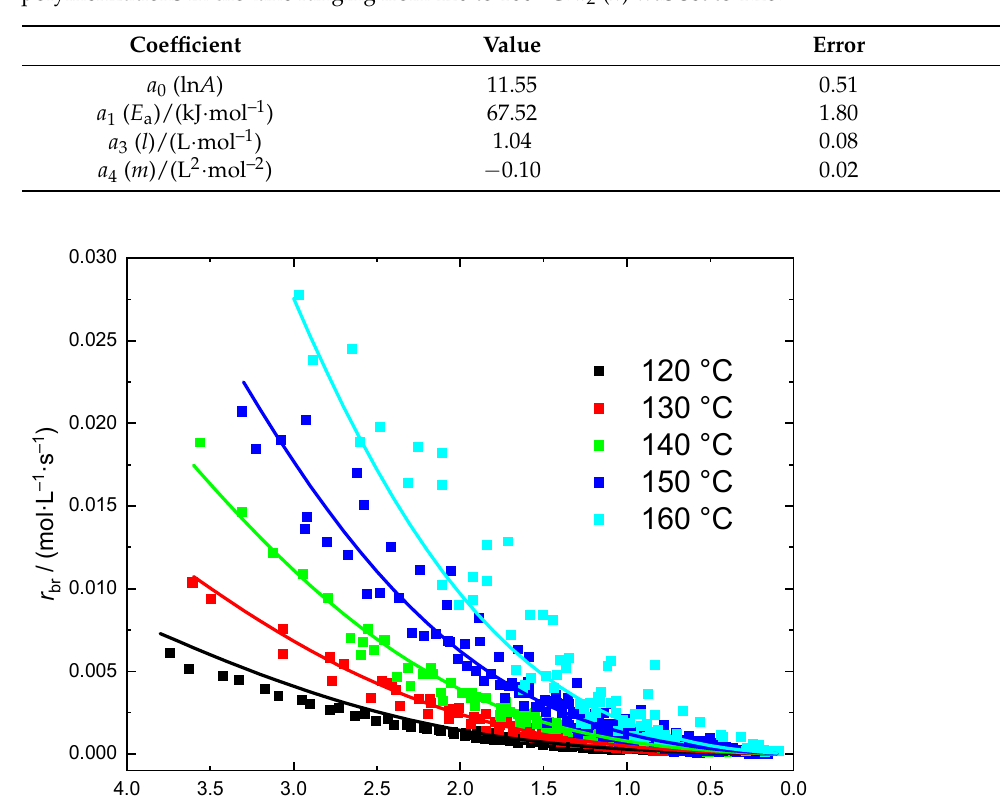
Table 3. Estimated coefficients a 0 , a 1 , a 3 and a 4 of the model represented by Equation (11) for polymerizations in dioxane ranging from 120 to 160 ◦ C. a 2 ( n ) was set to 1.28.